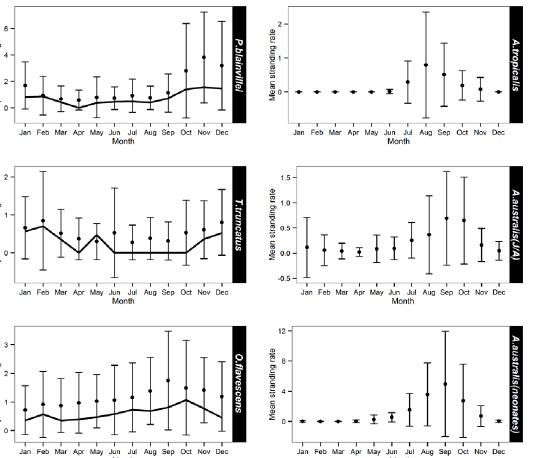
Fig 5. Mean stranding rate of frequent species by month from 1976 to 2013. Black line represents the stranding rate of carcasses in which the cause of death was attributable to bycatch. Y-axes in the left graphics are on a square-root scale for ease-of-read purpose. Only stranding records from areas 2 and 3 were